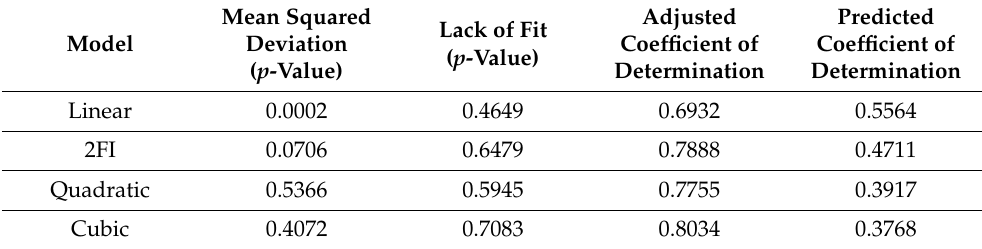
Table 12. Simulation of four models in the design expert weld width.